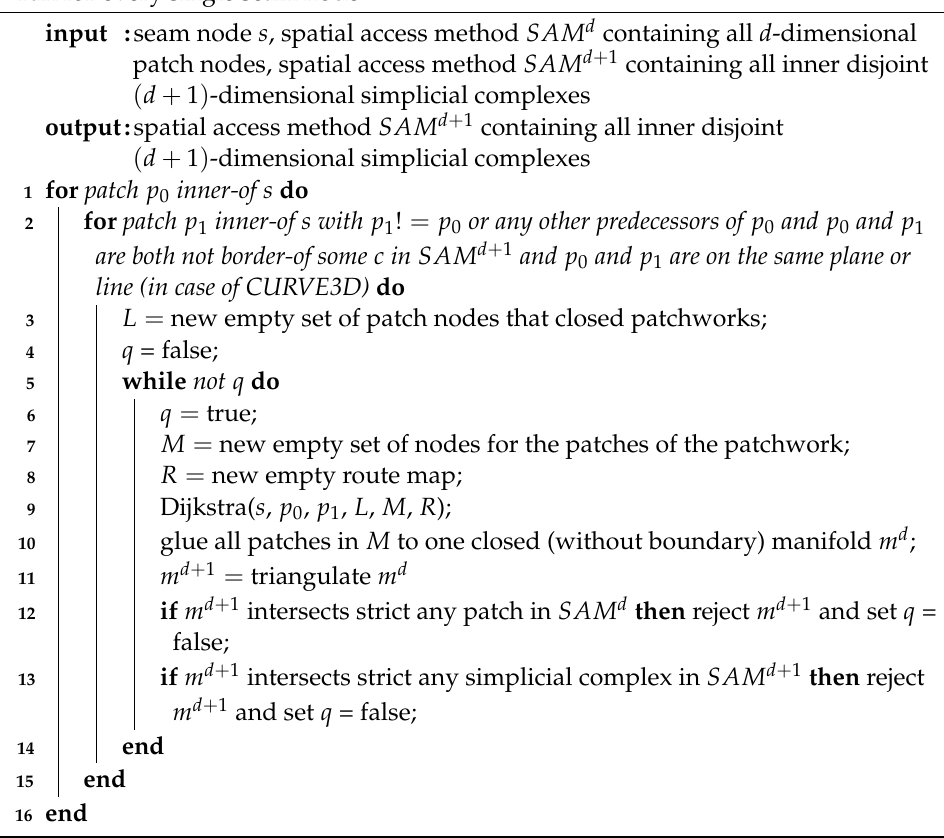
Algorithm 2: Run() operation of a thread for Step 6 of Algorithm 1—needs to run for every single seam